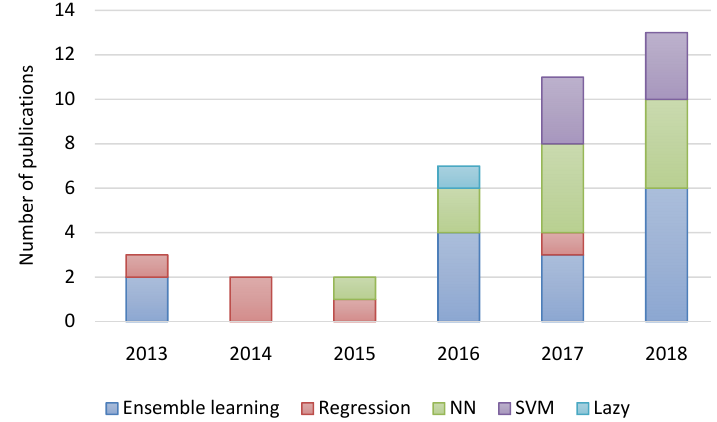
Fig. 3: Number of studies based on different machine learning algorithms from 2013 to 2018